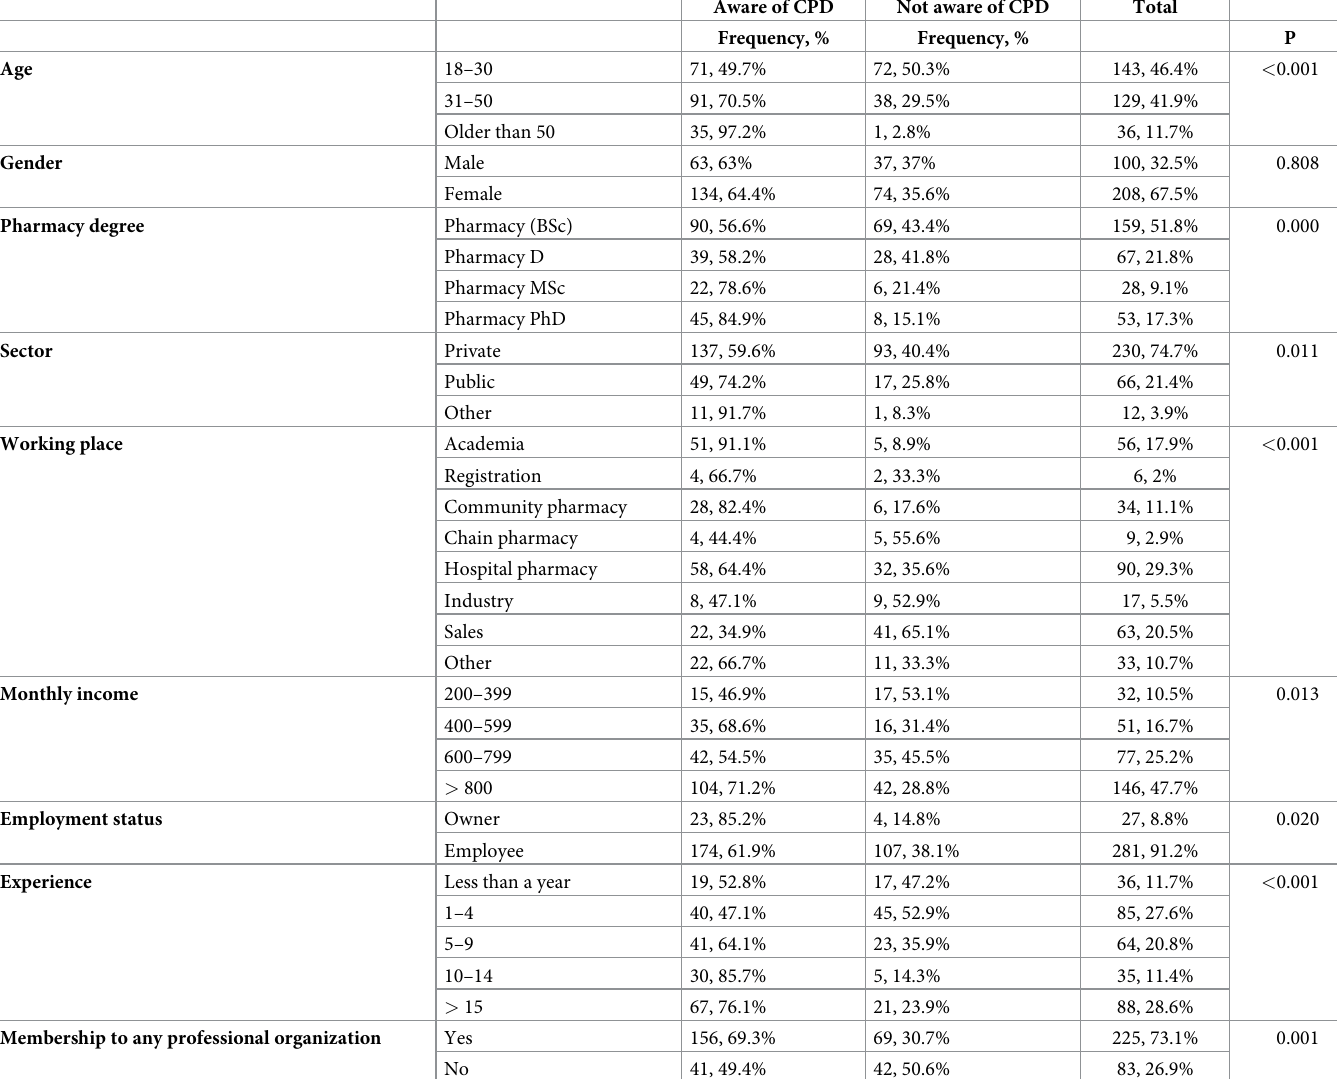
Table 1. Comparison of demographic data between participants who are aware about CPD and those who are